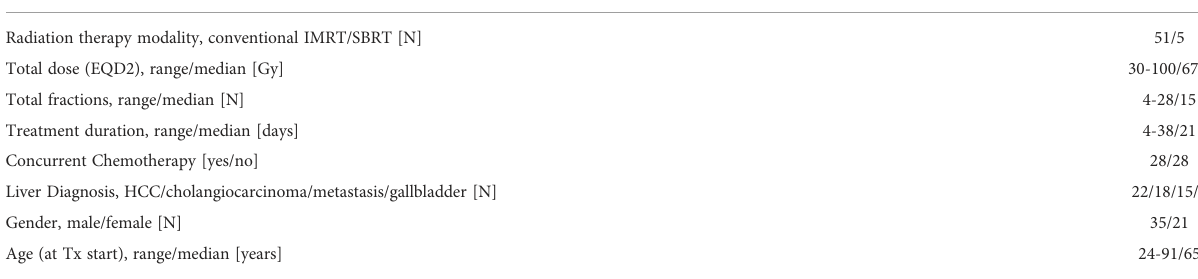
TABLE 1 Treatment parameters for patients in the dose accumulation